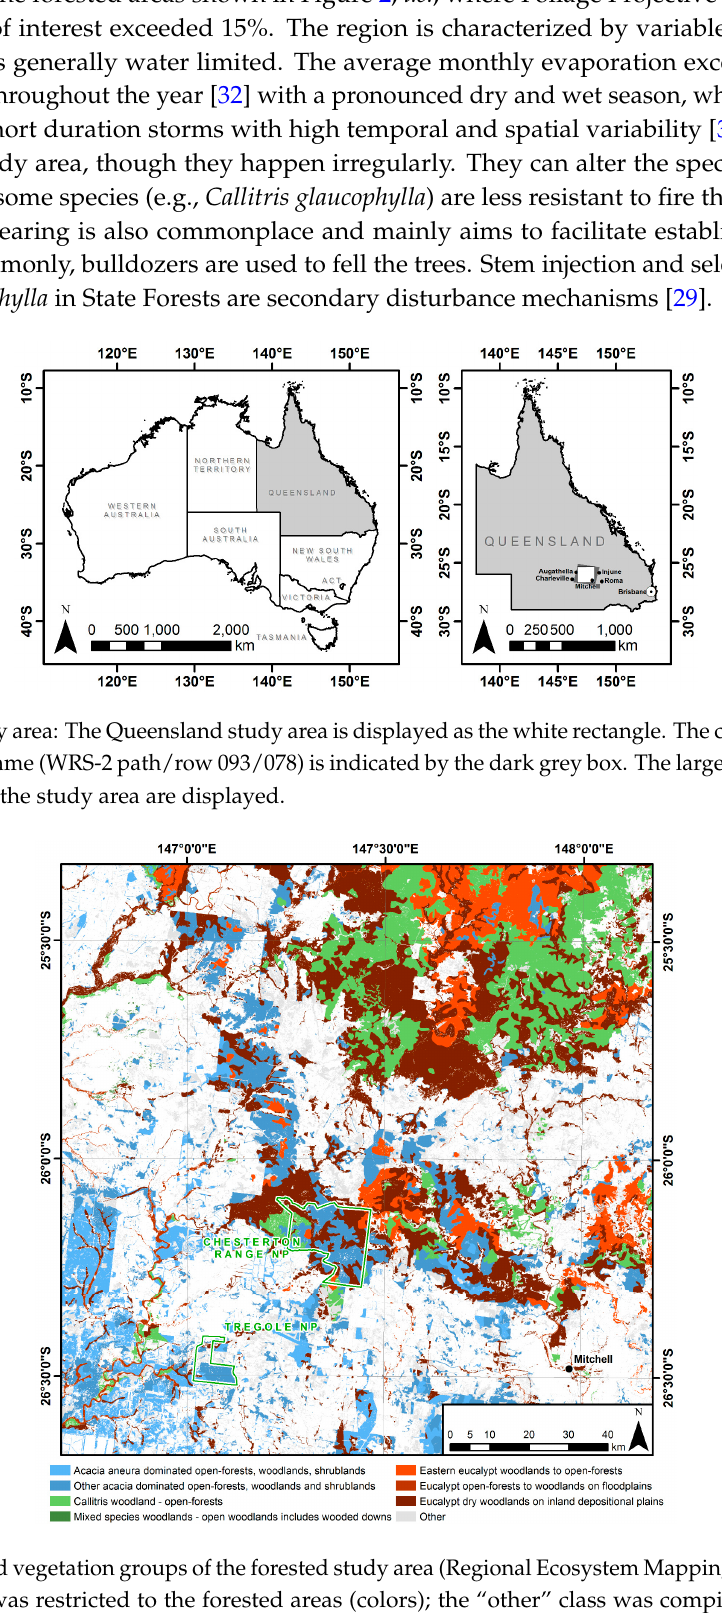
Figure 2. Broad vegetation groups of the forested study area (Regional Ecosystem Mapping of 2006 [30]). The analysis was restricted to the forested areas (colors); the “other” class was compiled using the 15% Foliage Projective Cover threshold, and is mainly composed of grasslands and previously cleared forests. The outlines of the National Parks are superimposed in green